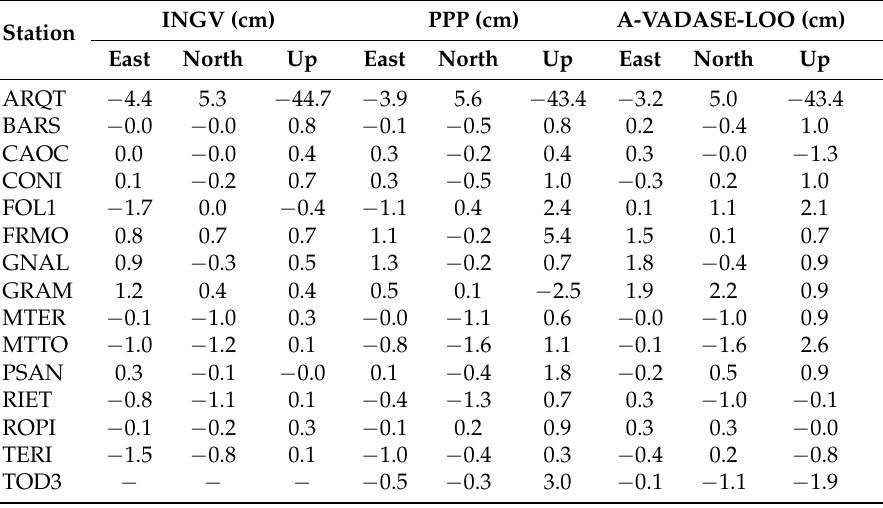
Table 7. Coseismic displacements: 30 October 2016